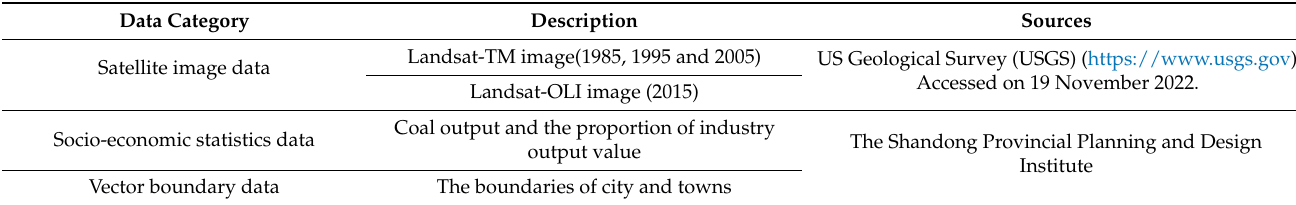
Table 1. Data categories and sources.